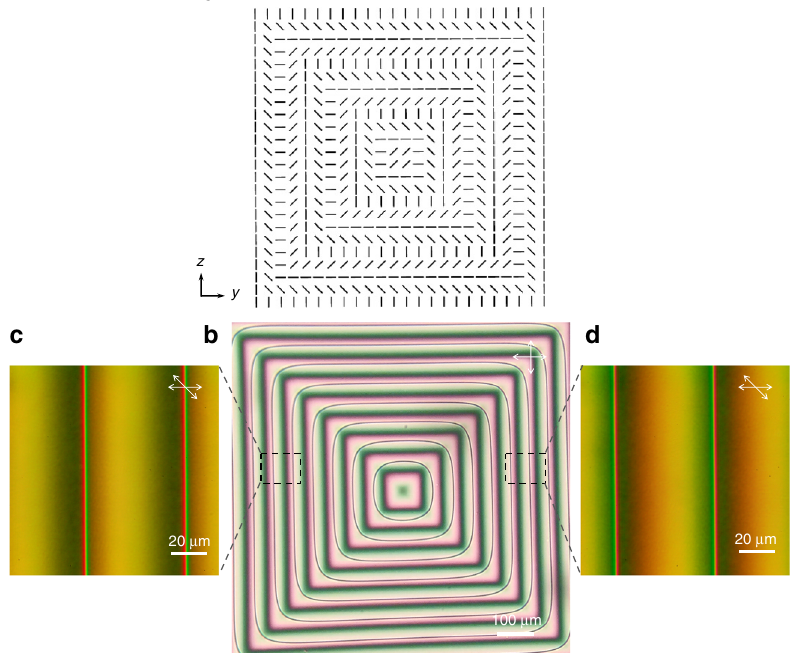
Fig. 1 Square surface alignment pattern and the array of 1/2-strength twist disclination lines. a The designed square pattern for surface photoalignment of nematic liquid crystal consisting of periodic and concentric orientational variations for the azimuthal anchoring direction. b Polarized micrograph of a liquid crystal cell held between the square patterned substrate and a uniformly surface-aligned substrate. For every pitch (53 μ m) of in-plane rotation of the director, a free-standing loop of twist disclination line is generated (seen as concentric loops of thin dark lines ). Except for the corner, the disclination lines follow the path where the alignment on the patterned surface is orthogonal to the uniform alignment on the opposite surface. c , d Magni fi ed views of b between obliquely oriented polarizers to indicate the continuous and asymmetric variation of the twist states across the disclination lines that appear as sharp colored lines in the fi gure. The disclination lines in c , d are of the opposite handedness; in c , the left ( right ) side of the disclination is associated with – π /2 ( π /2) twist from the bottom to the top surface , corresponding to the plus sign in Eq. (1) and hence is of the right handedness. That in d is of the left handedness. The oppositely twisted states across the disclination line give an asymmetric contrast under obliquely aligned